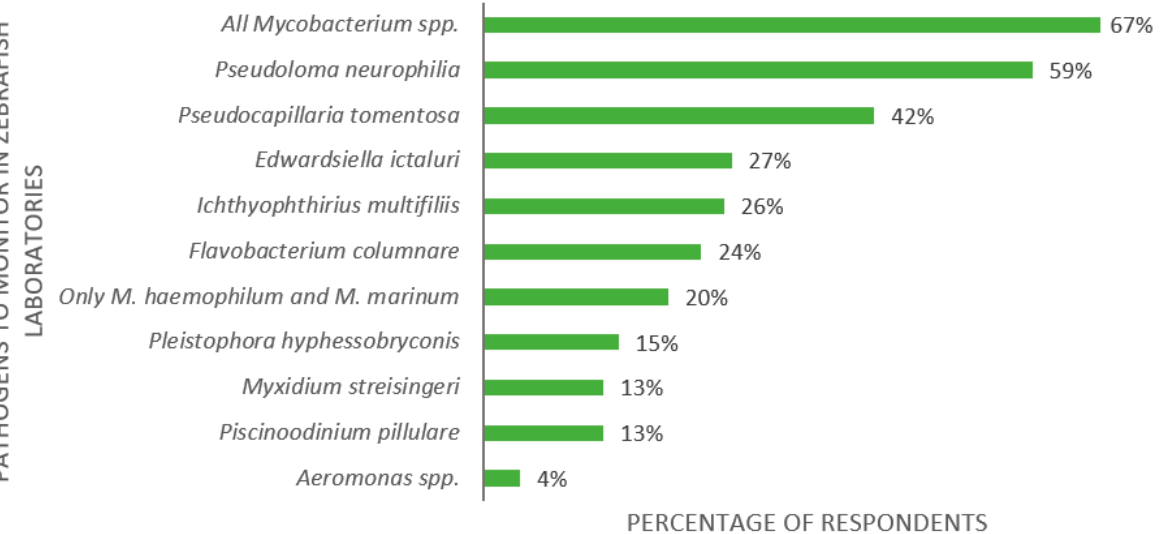
Figure 6. Replies to the multiple-choice question: “What do you think are the main pathogens to monitor in the zebrafish laboratory?”, presented as percentage of respondents ( n = 123). Each respondent was allowed to select multiple answers.